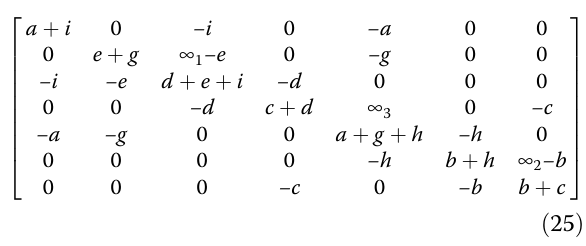
Where fp represents the stop-band central frequency, Qp represents the quality factor, K represents the pass- band voltage magnification.